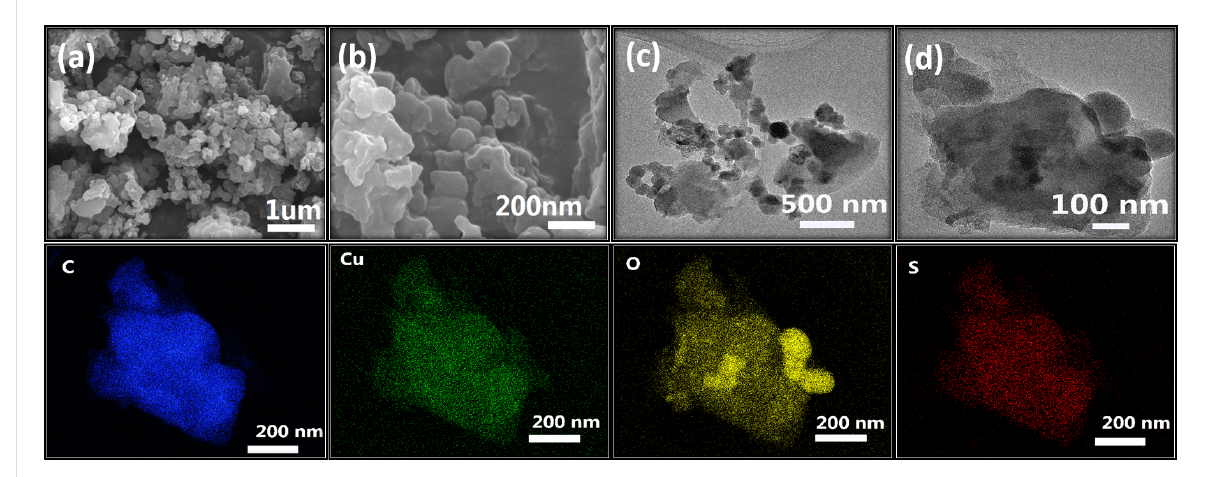
Figure 4: FSEM imagine of LS-FAS-Cu in different scale label a) 1 μ m, b) 200 nm; FTEM images of LS-FAS-Cu in 500 nm (c) and 100 nm (d); and the elemental mapping of LS-FAS-Cu for C, Cu, O and S elements.